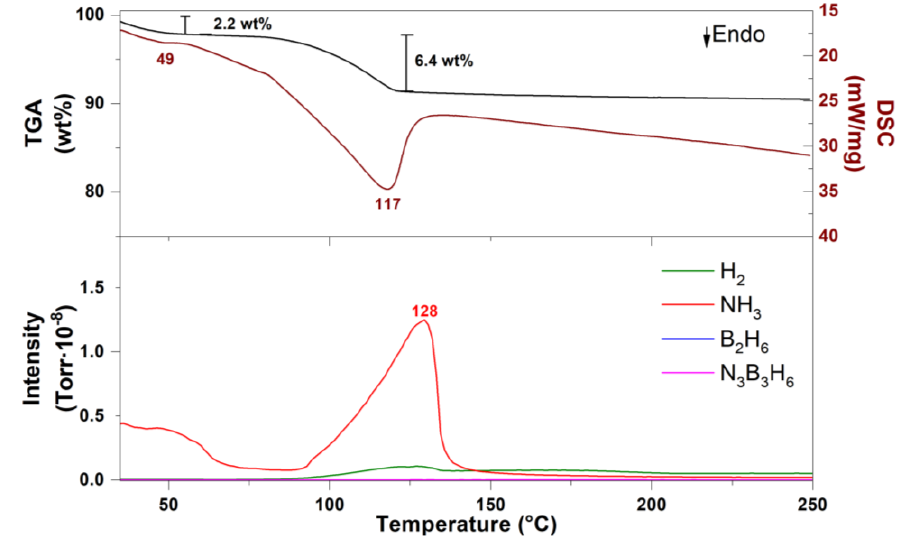
Figure 7. ( Top ) TGA/DSC for sample s2 during heating from 30 to 250 °C (Δ T/ Δ t = 5 °C/min, 40 mL/min argon flow). ( Bottom ) Corresponding MS signals.